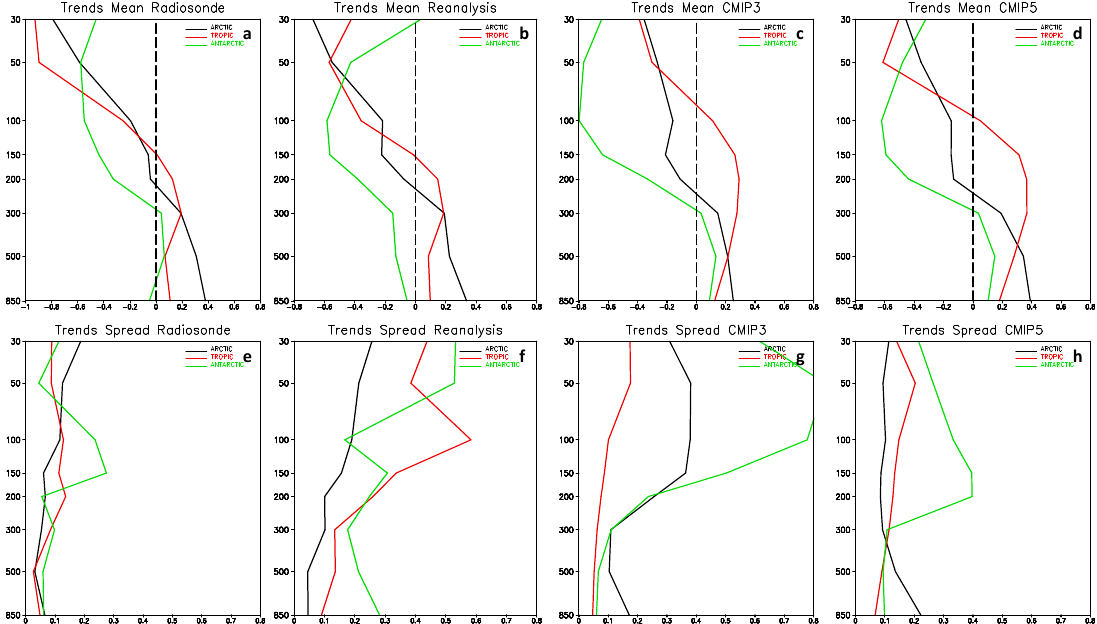
Fig. 5. Vertical profiles of the ensemble mean trends and spreads ( ◦ Cdecade − 1 ) for the Arctic, tropic and Antarctic temperature from 1979 through 2005. Ensemble mean trends: (a) radiosonde, (b) reanalysis, (c) CMIP3 and (d) CMIP5; ensemble spread trends: (e) radiosonde, (f) reanalysis, (g) CMIP3 and (h)